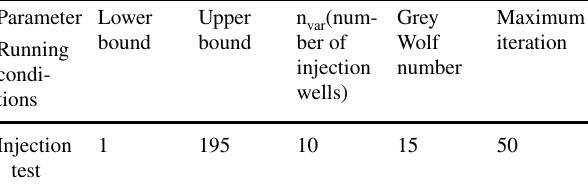
Table 3 Running conditions of GWO optimization algorithm under